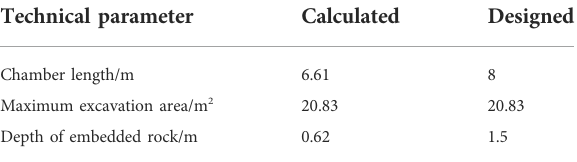
TABLE 3 Mine waterproof wall design